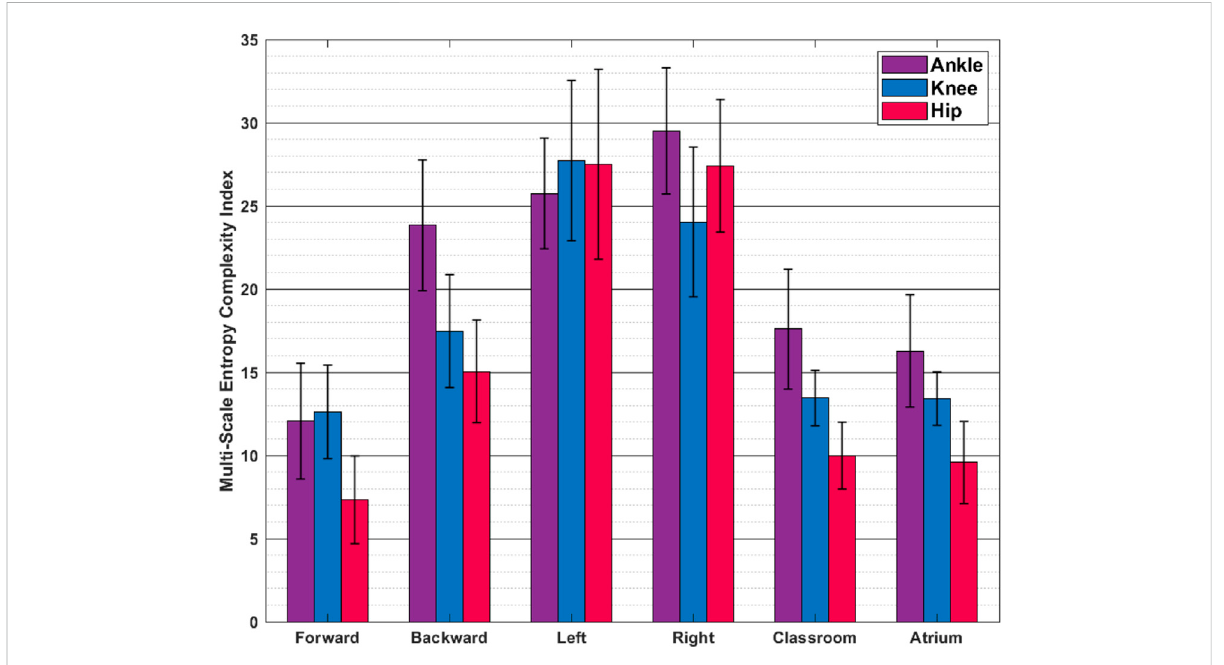
FIGURE 8 MultiscaleEntropy(Mean ± SD)The values reported are mean and standard deviation across thetrials from all thesubjects. Sidestepping shows greater irregularity and thus complexity, than other